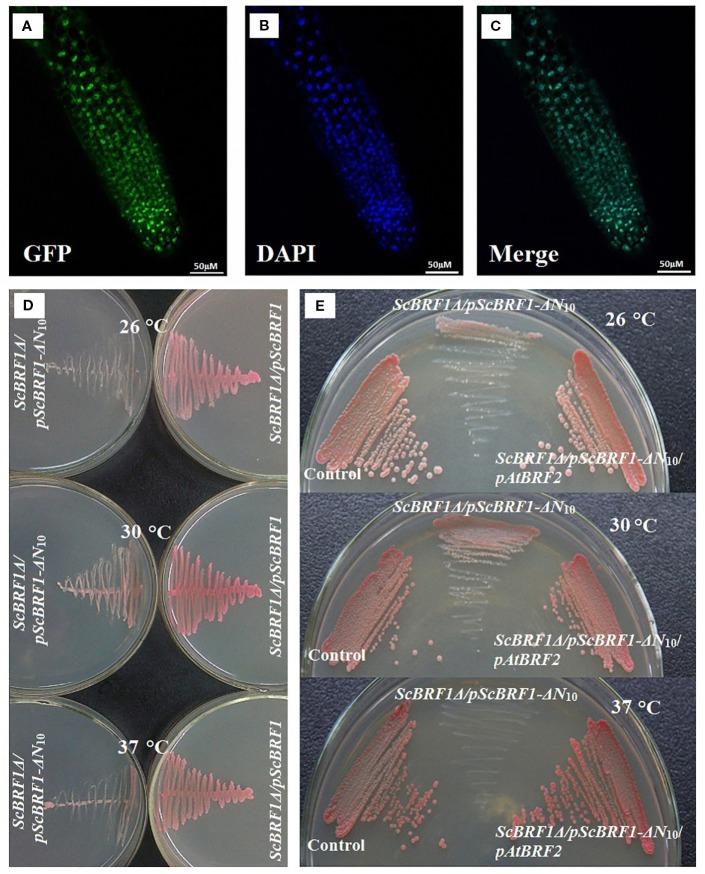

Arabidopsis BRF2 complements the thermotolerance defect of S. cerevisiae brf1 mutant. (A–C) Confocal images illustrating subcellular localization of the BRF2-GFP fusion protein in Arabidopsis roots. The green fluorescent image of BRF2-GFP fusion (A) and the blue fluorescent of nucleus stained with DAPI (B) are merged into (C). (D) The substitution of ScBRF1 with an N-terminal truncated fragment (harbored in pScBRF1-ΔN10 plasmid) resulted in defect in growth, especially at adverse temperatures. (E) The susceptibility of ScBRF1Δ/pScBRF1-ΔN10 strain to adverse temperatures was remedied by overexpression of the Arabidopsis BRF2. W303 strain with pJFE3 and pYX242WS vectors was used as a control.